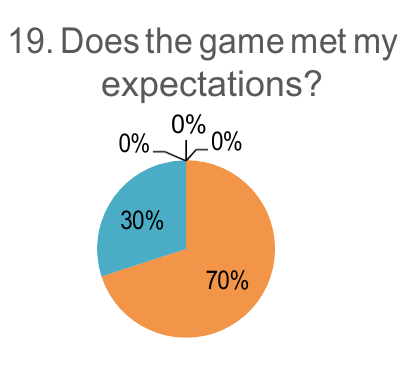
Figure 7. Anxiety or boredom during play.